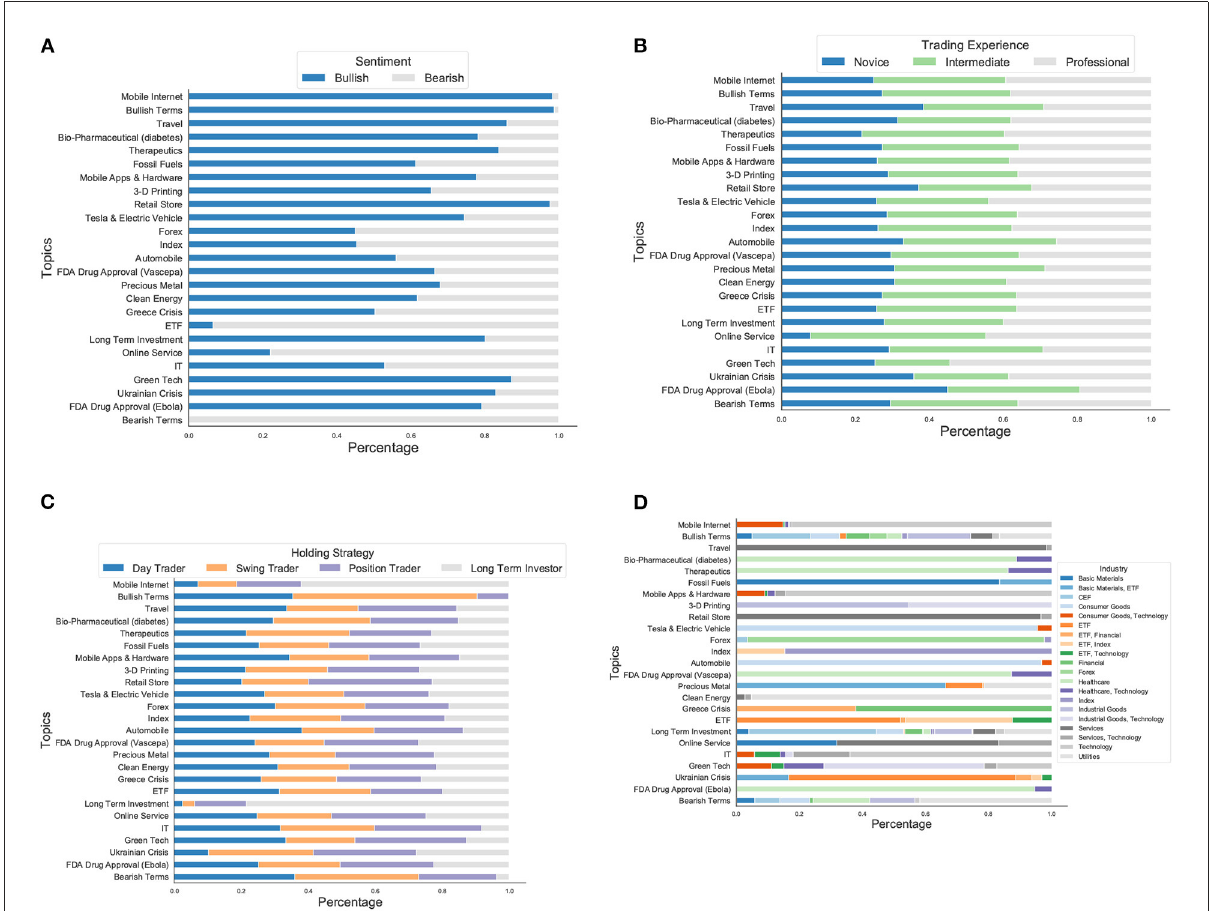
FIGURE5 (A) The heterogeneity of investor sentiment in each topic in terms of bullish/bearish sentiment. The market sentiment is overall more bullish than bearish. (B) The heterogeneity of investor sentiment in each topic in terms of trading experience compositions. The investors with different trading experiences show considerable divergence on topics they are interested in. (C) The heterogeneity of investor sentiment in each topic in terms of holding strategy compositions. Investors with different trading strategies have divergent focuses and word preference across topics. (D) The distributions of asset categories across topics. Several topics are related to specific asset categories, and the belonging tweets contain discussions of the companies from the same asset category or associative industrial fields. Furthermore, we found that topics of important social events contain many company tickers that reveal the underlying associative asset categories under discussions of the